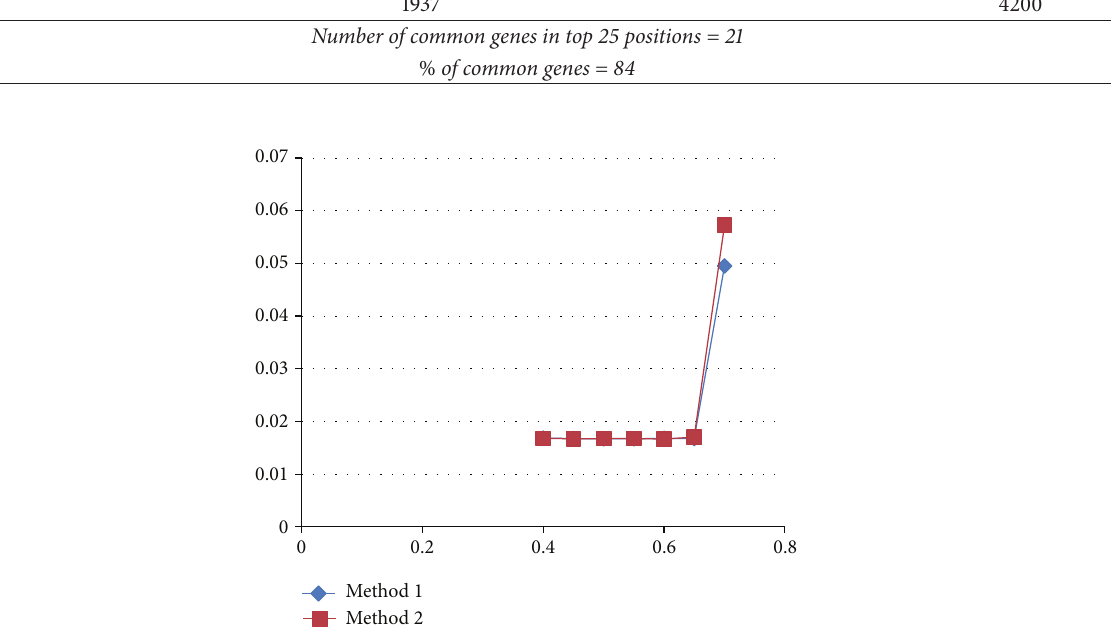
Figure 4: Plot of RMSE versus membership grade 𝜃 for cdc15